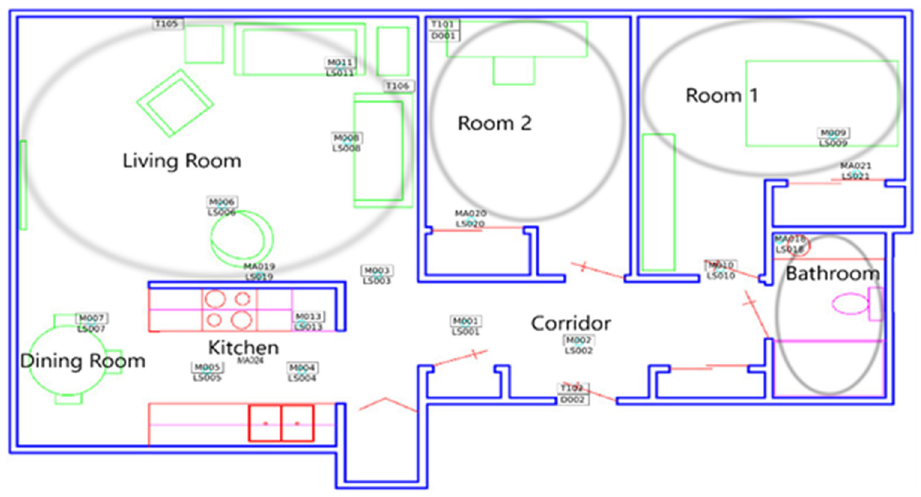
Figure 10. CASAS testbed (HH124) distribution.